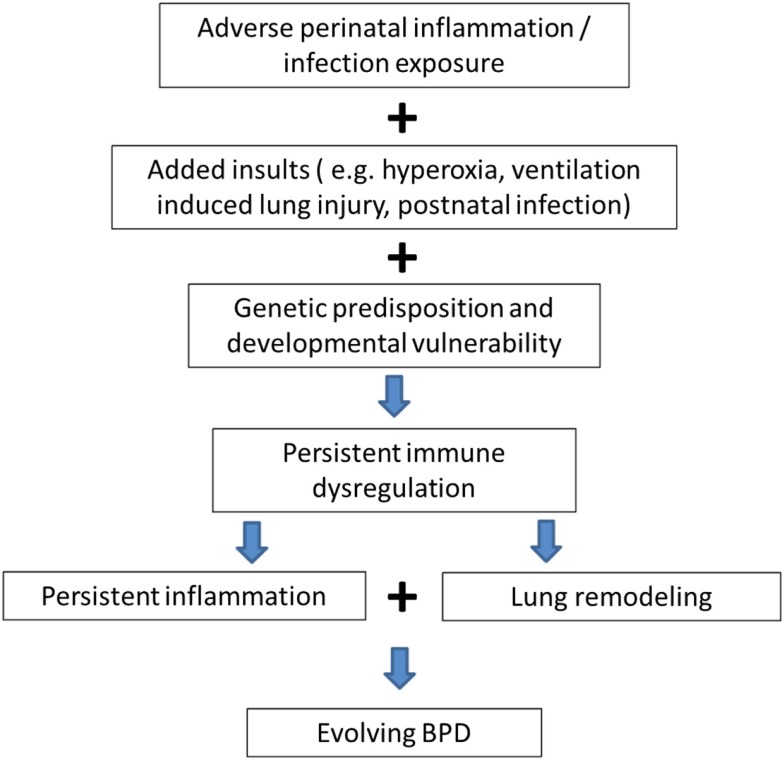
Genetic predisposition and persistent inflammation due to environmental factors (sepsis, invasive mechanical ventilation, and hyperoxia) acting on the foundation of immature lung underlie the pathogenesis of BPD.